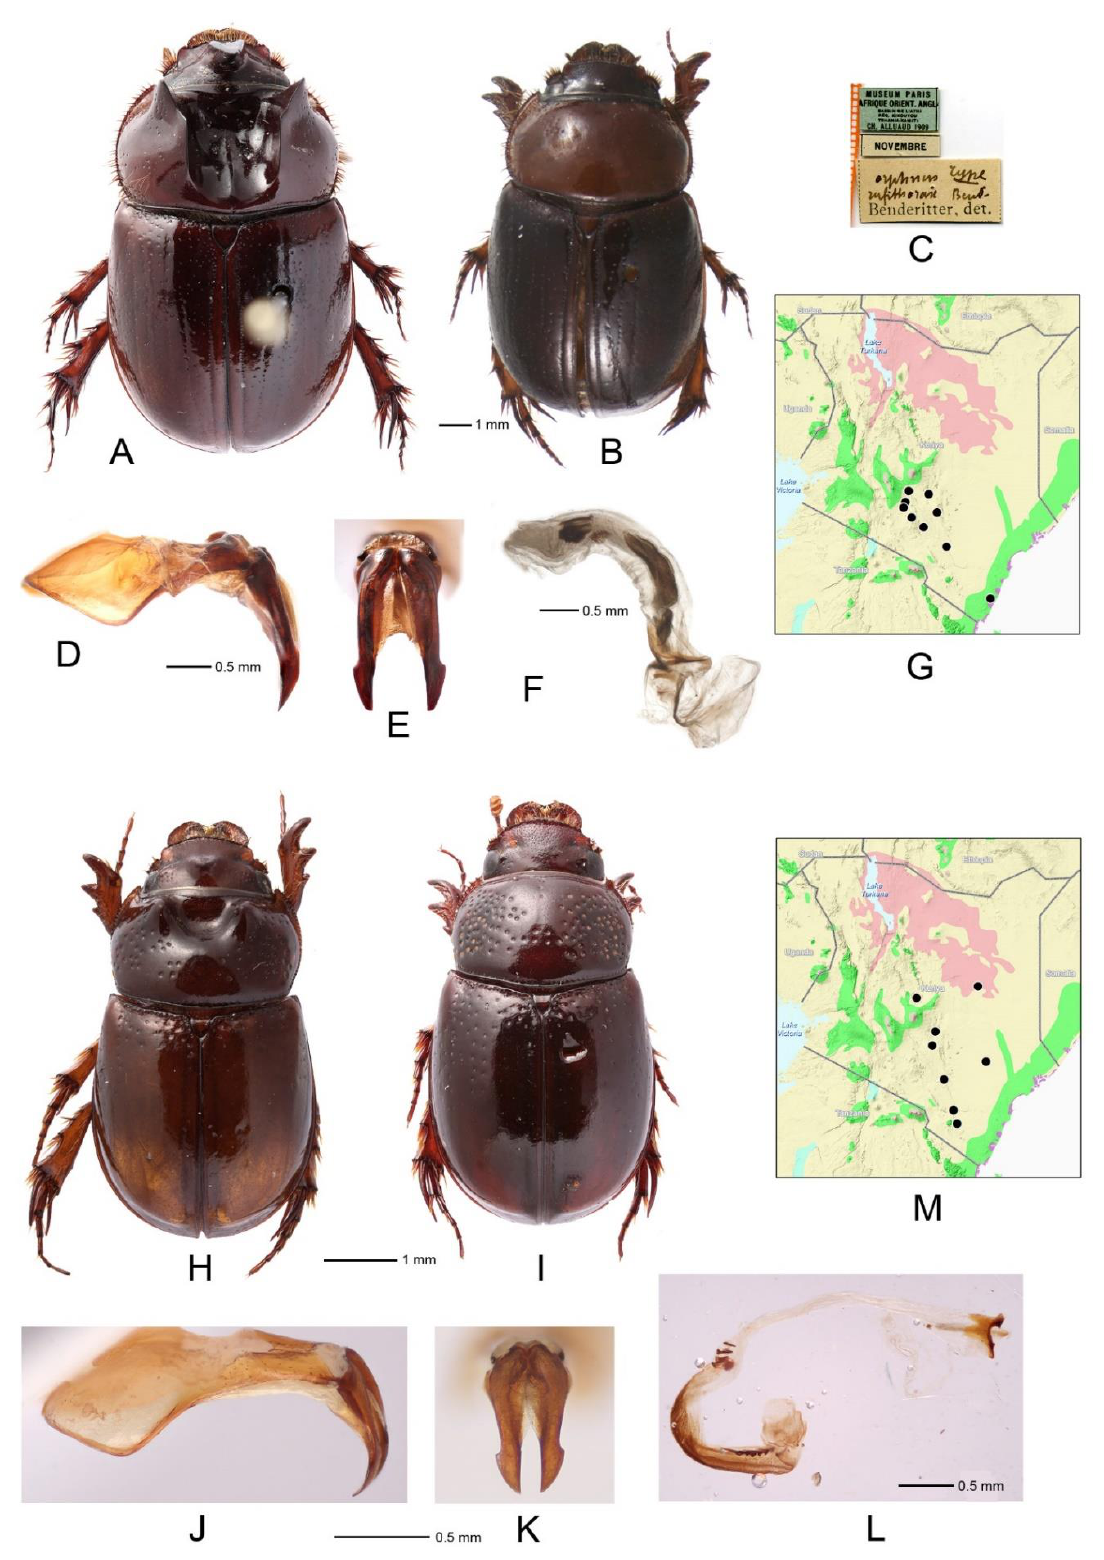
Figure 1. Orphnus rufithorax Benderitter, 1914 ( A – G , ( B , C , lectotype)) and O. thoracicus Linell, 1896 ( H – L ). ( A , H ) male, habitus; ( B , I ) female, habitus; ( C ) labels; ( D , J ) aedeagus in lateral view; ( E , K ) parameres in dorsal view; ( F , L ) endophallus; ( G , M ) distributional record map.